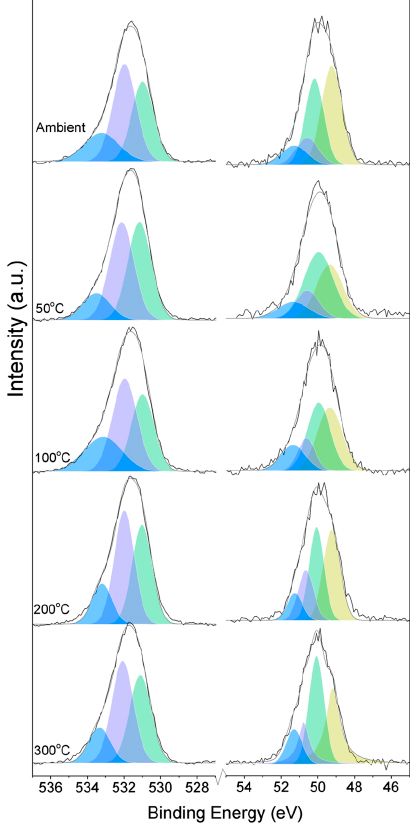
Figure 1. O1s ( left ) and Mg2p ( right ) peaks for samples exposed to different temperatures.